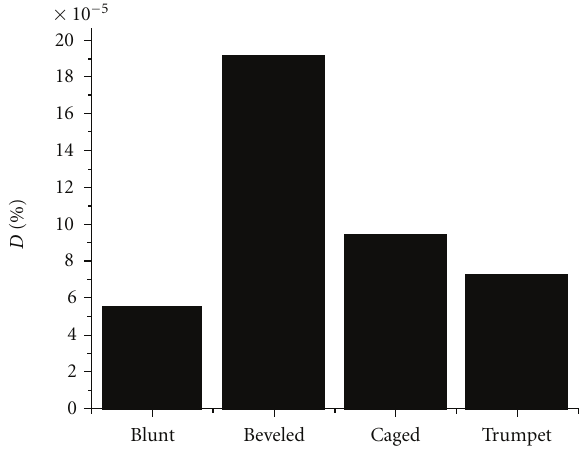
Figure 7: Blood damage index of inflow cannula.